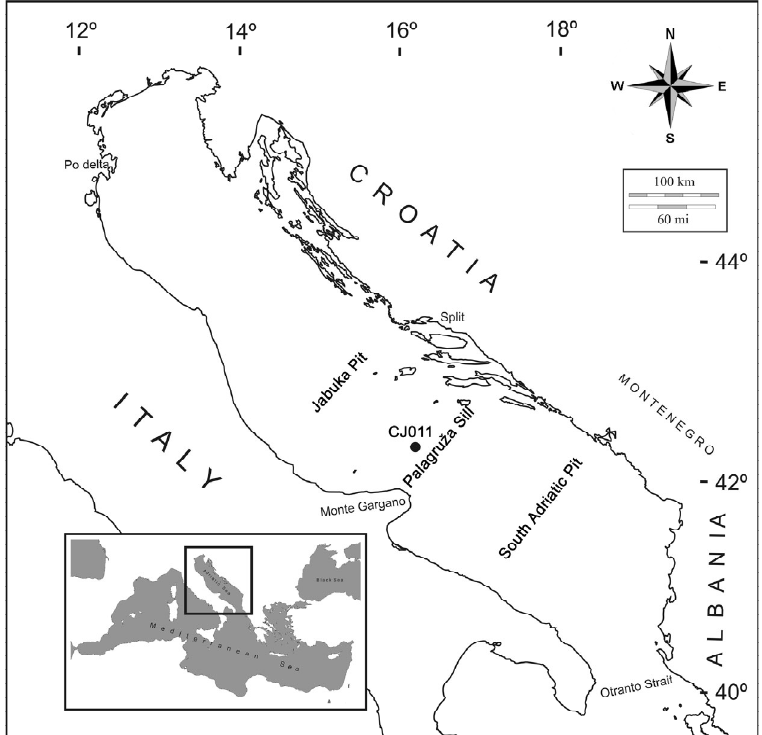
Figure 1. Study area with a sampling station.